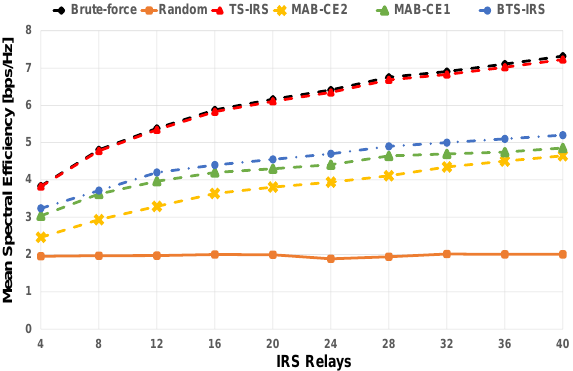
Figure 2. Mean spectral efficiency versus IRS relays [35].